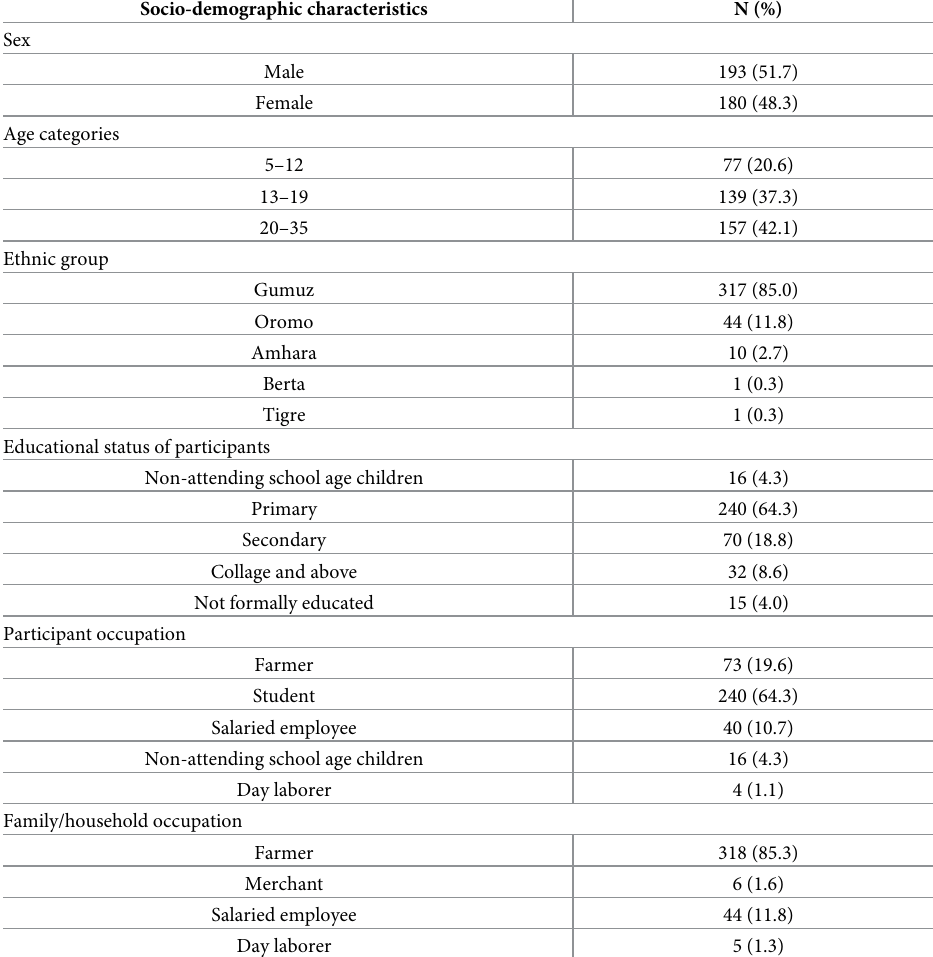
Table 1. Socio-demographic characteristics of study participants (n =